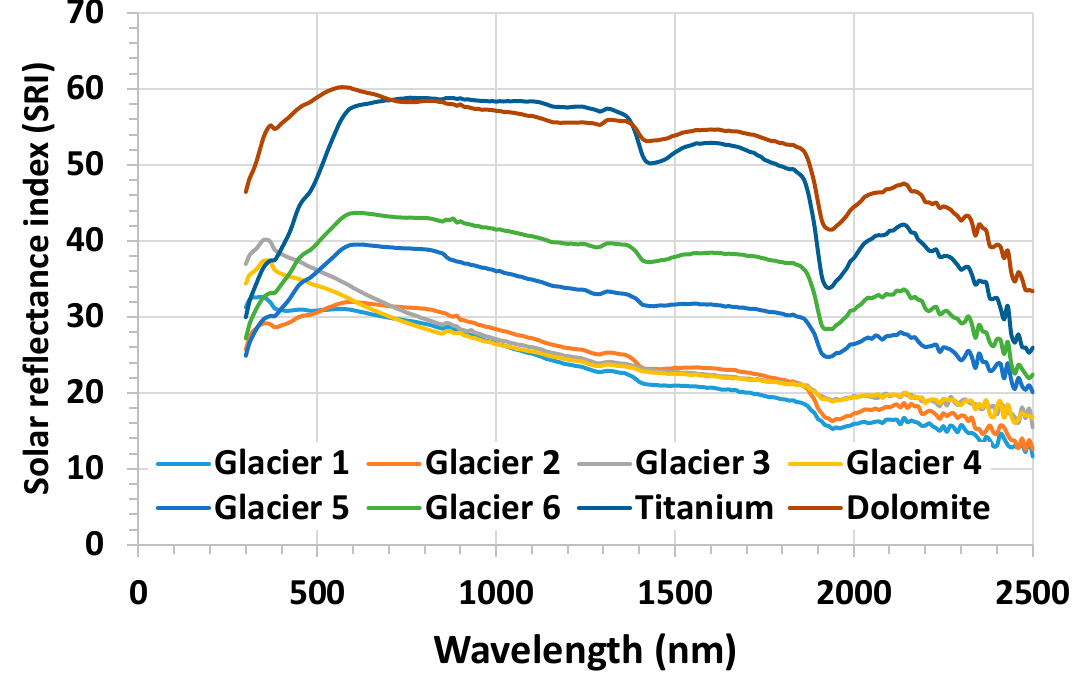
Figure 3. Solar reflectance index (SRI) as a function of the wavelength.